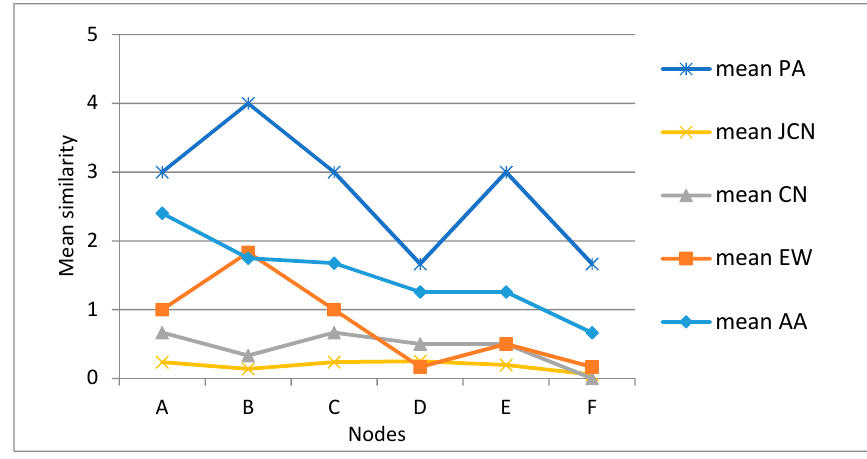
Figure 5. Neighbor based similarity scores for all nodes.